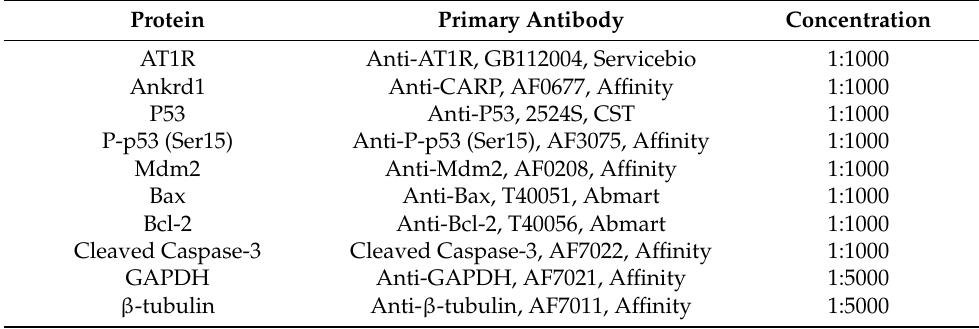
Table 1. Primary antibody used for Western blot in this